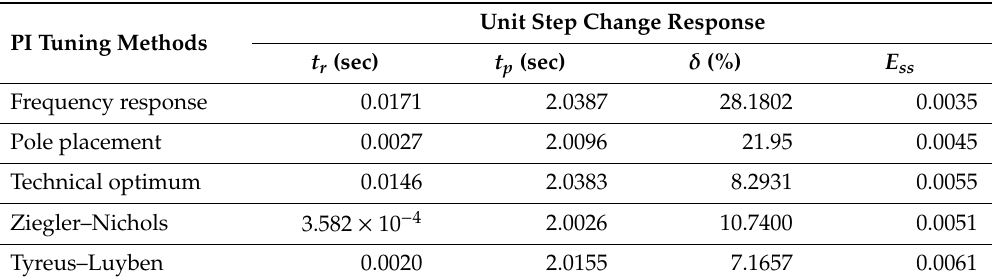
Table5. Time-domainperformancesforcontrolledquadraturegridcurrentunderastepchangescenario.